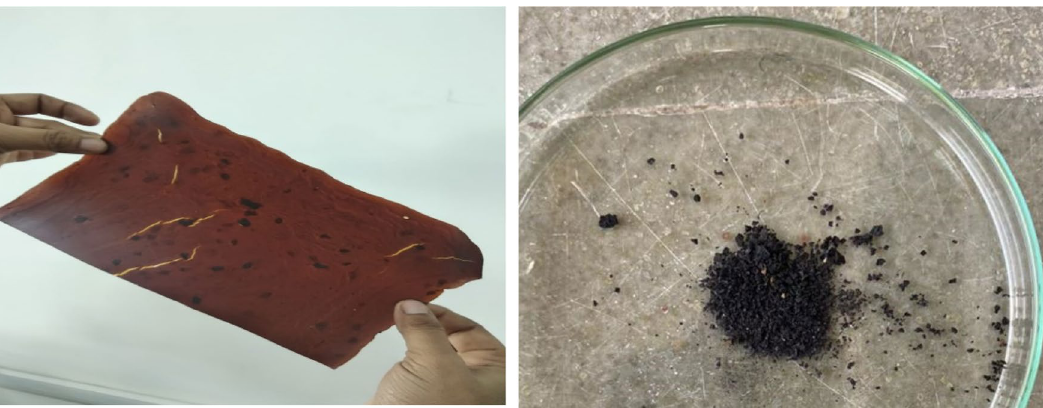
Figure 1. Graphene oxide (GO) sheet and strontium ferrite and graphene oxide composite ( SF@GOC